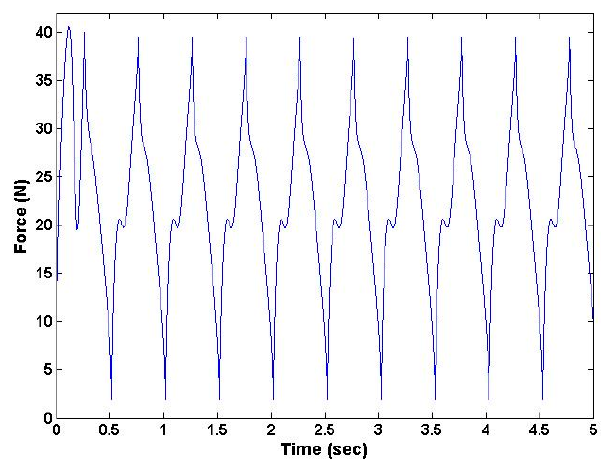
Figure 7. SimMechanics generated waveform showing maximum of 40 N with 2 Hz frequency of the device.